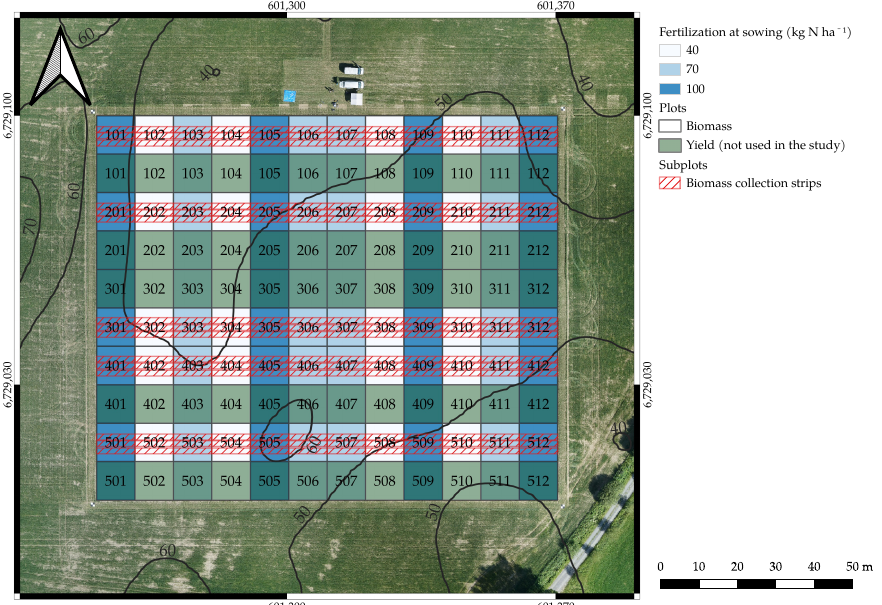
Figure 1. Layout of the experiment depicting fertilization levels, varied across the plot columns to obtain a dataset with wide ranges of biophysical and biochemical crop parameter values. The numbers indicate distinct plot pairs, and the rows of plots from which biomass samples were collected are indicated. The three passes of the grass harvester along each of the rows are also marked. Apparent soil electrical conductivity measurements are displayed in mSm − 1 using isolines. The coordinates are in the system described by the EPSG:25832 code.